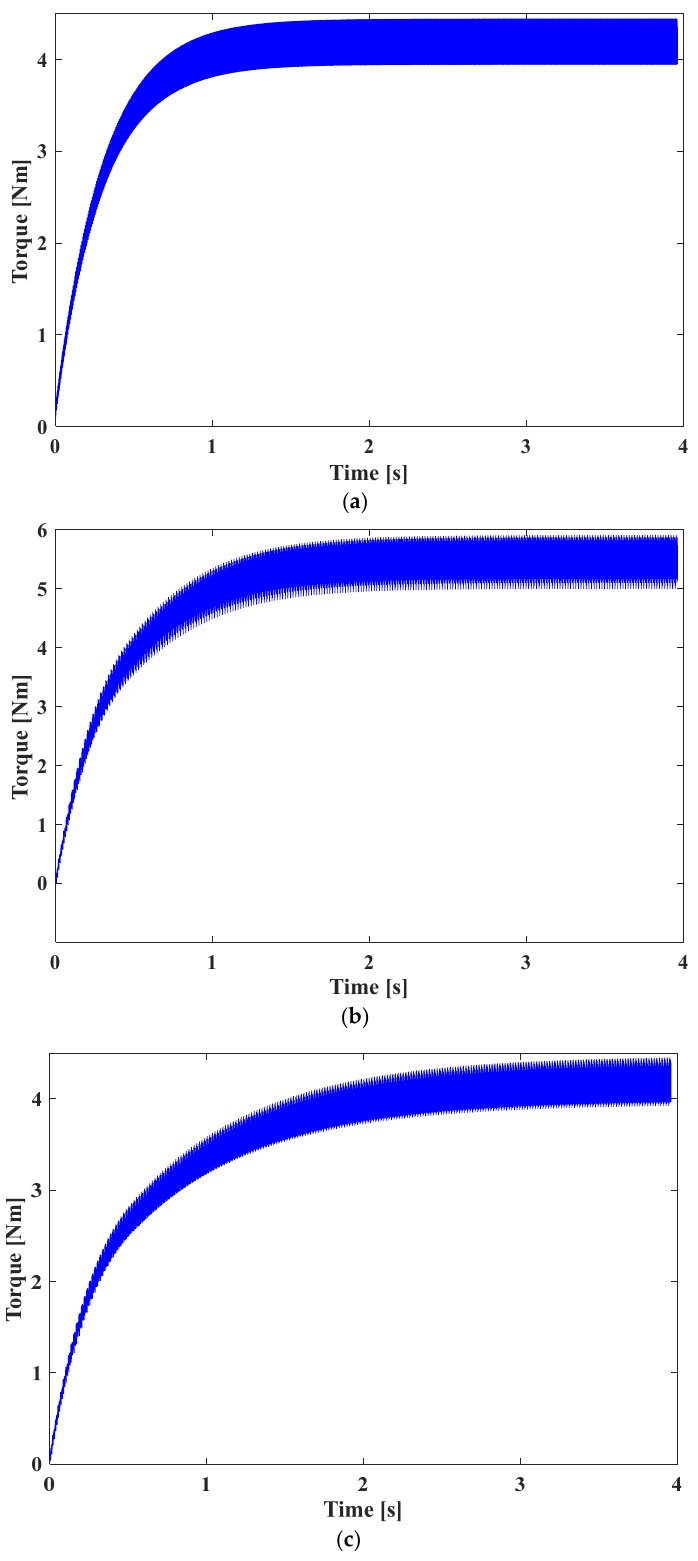
Figure 11. Torque produced by ( a ) reference machine, ( b ) proposed machine case 1, ( c ) proposed machine case 2.